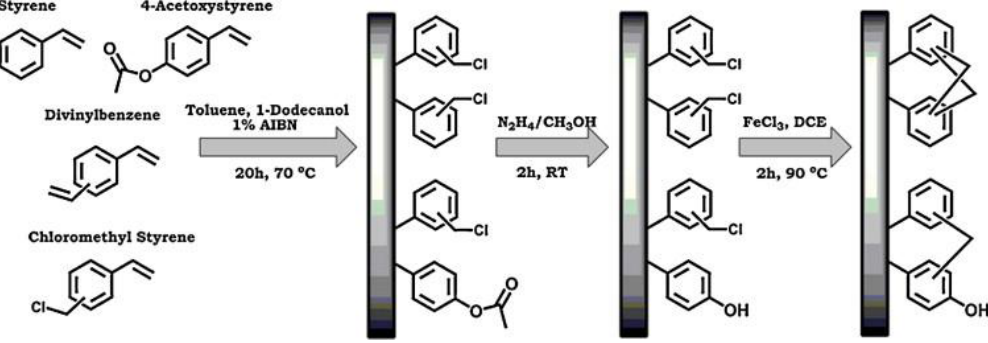
Figure 4. Schematic representation of the preparation of hyper-crosslinked monoliths with phenol functionalities using copolymerization of 4-acetoxystyrene, followed by deprotection and hyper-crosslinking. Reprinted from ref. [70], Copyright 2013, with permission from Elsevier (Amsterdam, The Netherlands).